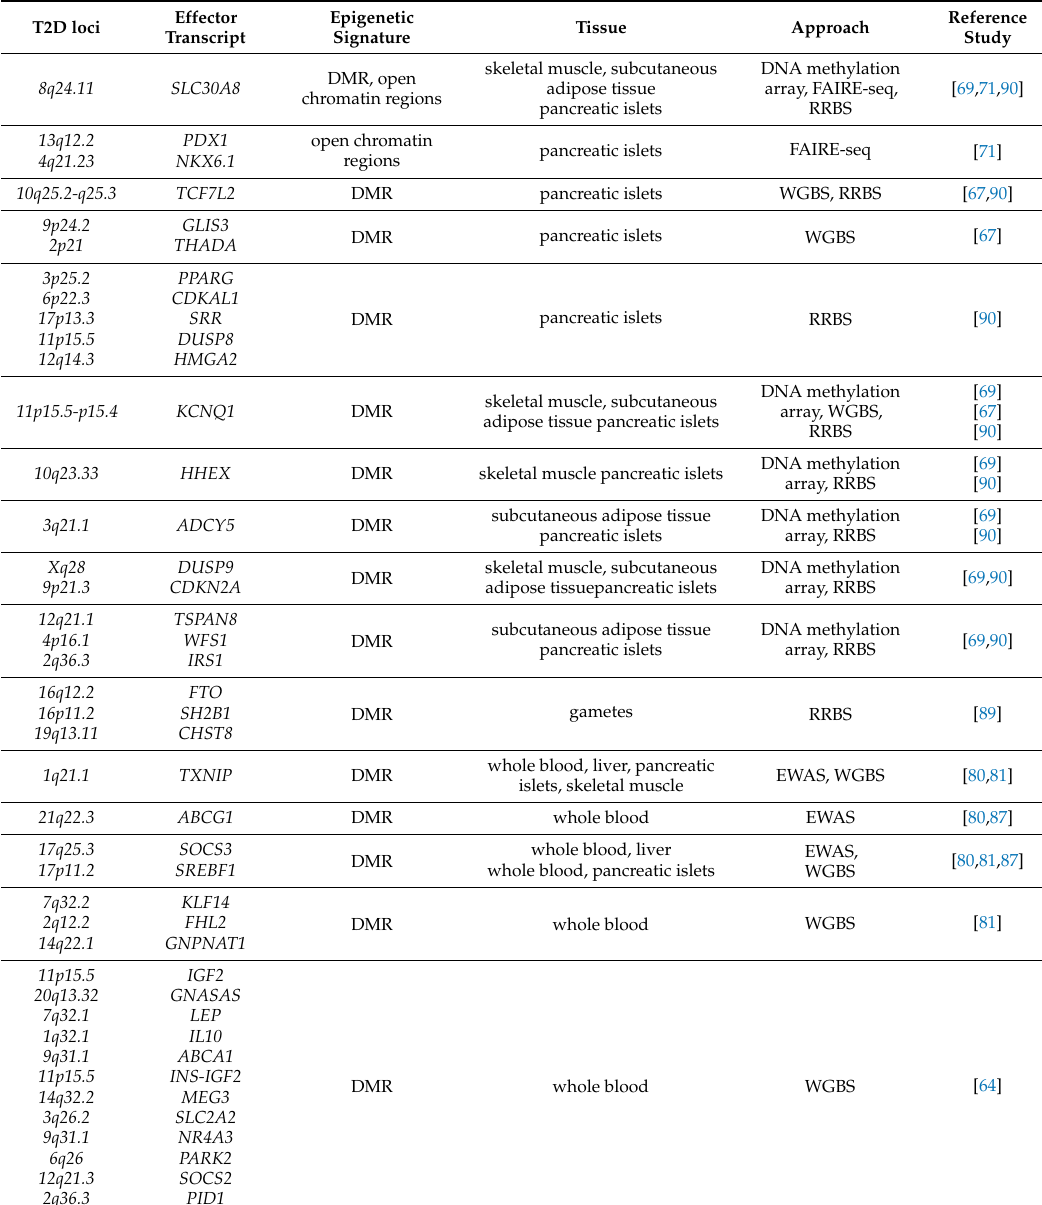
Table 2. T2D associated genetic loci and their transcript genes regulated via epigenetic mechanisms. T2D loci Effector Transcript Epigenetic Signature Tissue Approach Reference Study skeletal muscle, subcutaneous adipose